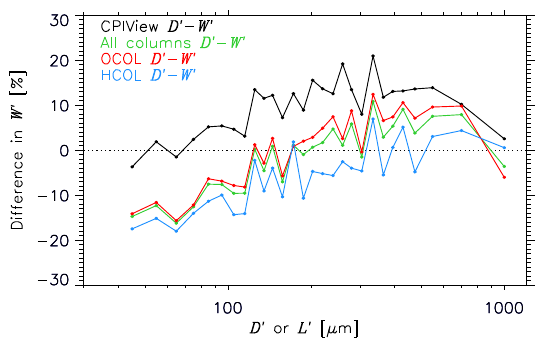
Figure 15. Calculated differences between W (cid:48) s of HCOLs de- rived from L (cid:48) – W (cid:48) relationships for HCOLs and four different W (cid:48) s derived from D (cid:48) – W (cid:48) relationships (i.e., CPIView, all columns, OCOLs, and HCOLs) for the same D (cid:48) corresponding to the L (cid:48) of HCOLs. Differences are calculated as 100 × ( W (cid:48) of y − W (cid:48) of HCOL ( L (cid:48) – W (cid:48) relationship)) / ( W (cid:48) of HCOL ( L (cid:48) – W (cid:48) relationship)), where four different y relationships are indicated in the figure